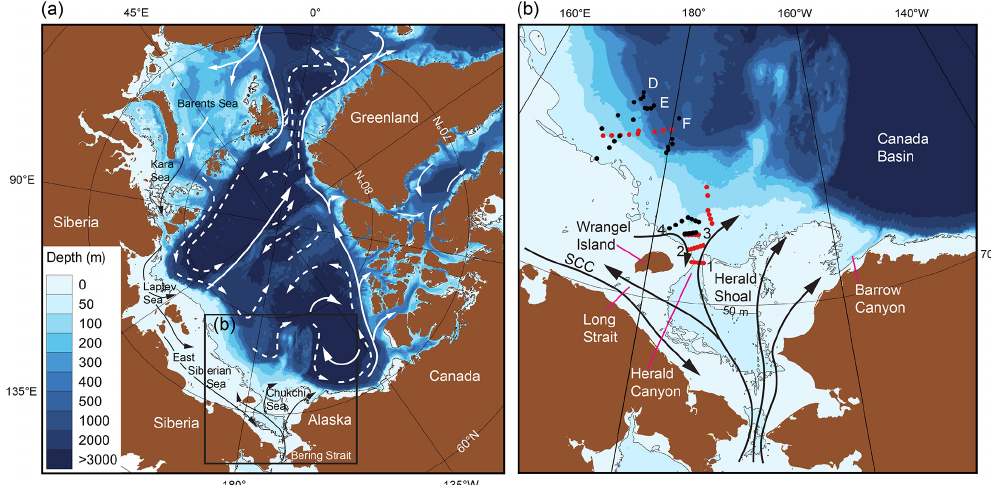
Figure 1. Map of the Arctic Ocean (a) with the mean schematic oceanic circulation illustrated by solid arrow for surface currents, interrupted arrows for intermediate currents, and dotted arrows for deep currents. In panel (b) , a close-up of the eastern East Siberian Sea (ESS) and Chukchi Sea (CS), with stations noted from the International Siberian Shelf Study in 2008 (ISSS-08) (red dots) and Swedish–Russian– US Arctic Ocean Investigation of Climate-Cryosphere-Carbon Interactions (SWERUS-C3) (black dots). Herald Canyon sections are labelled with 1 to 4 and the continental slope sections are labelled D, E, and F. SCC denotes the Siberian Coastal Current. Bathymetry is from the International Bathymetric Chart of the Arctic Ocean (IBCAO) version 4.0 (Jakobsson et al., 2020). Please note the black dots overlying red ones in section